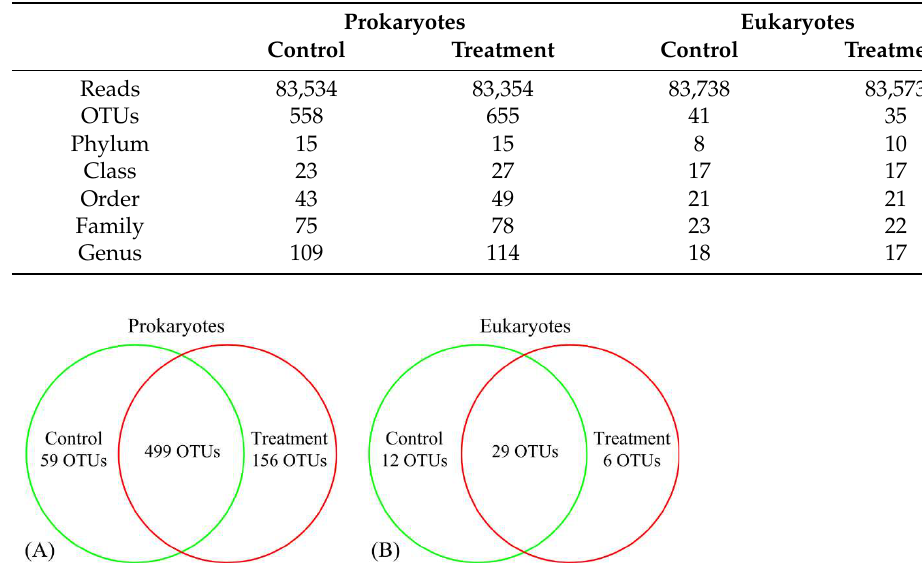
Figure 1. Venn diagrams showing the numbers of OTUs shared between the control and treatment groups for the prokaryotic ( A ) and eukaryotic ( B ) communities, respectively. Green cycles represent the control group and red cycles represent the treatment group.